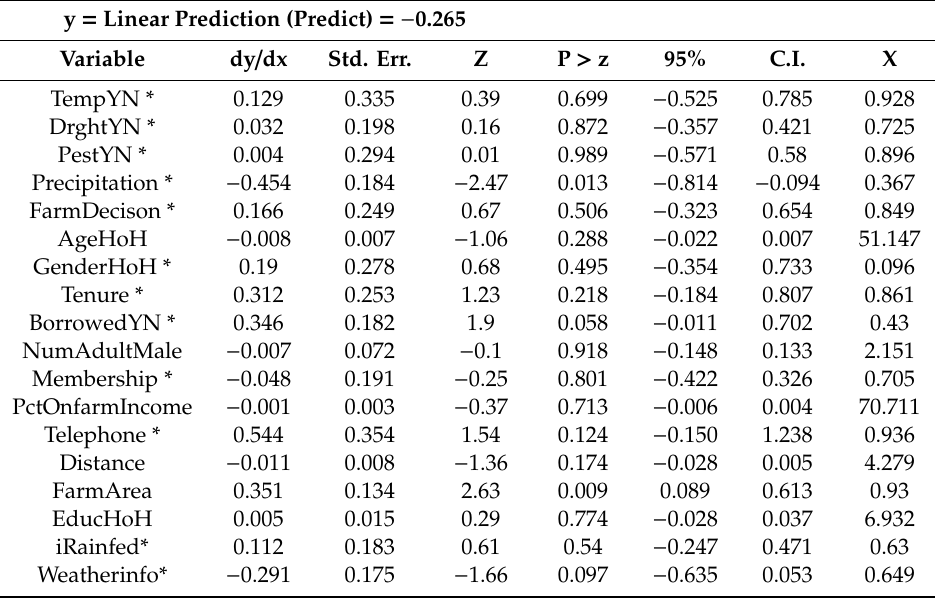
Table 5. Marginal e ff ect after multivariate probit analysis due to change in precipitation. y = Linear Prediction (Predict) = − 0.265